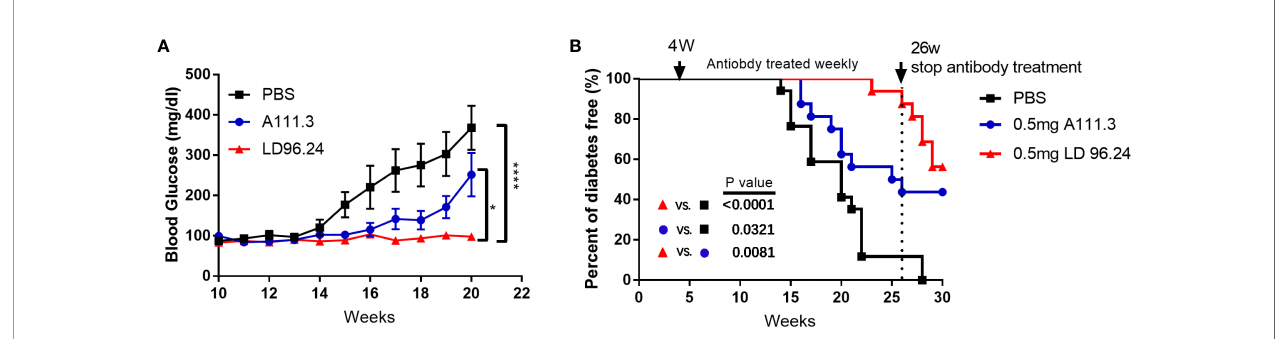
FIGURE 4 | Monoclonal antibody LD96.24 delays the onset of T1D. Groups of 4-week-old female NOD mice were treated weekly with PBS n = 18; black squares), 0.5 mg of LD96.24 (n = 18; red triangles), and 0.5 mg of isotype control antibody A111.3 (n = 18; blue circles) until 30 weeks. The blood glucose levels of each group were monitored weekly from 10 weeks of age. Mice were considered diabetic after two consecutive blood glucose concentrations ≥ 250 mg/dL. (A) The changes in the blood glucose level in each group. Data are means ± SEM. (B) The percentages of the remaining diabetes-free mice of each group are shown. The log-rank (Mantel – Cox) test was used for the survival plots. P-values were determined by using the c 2